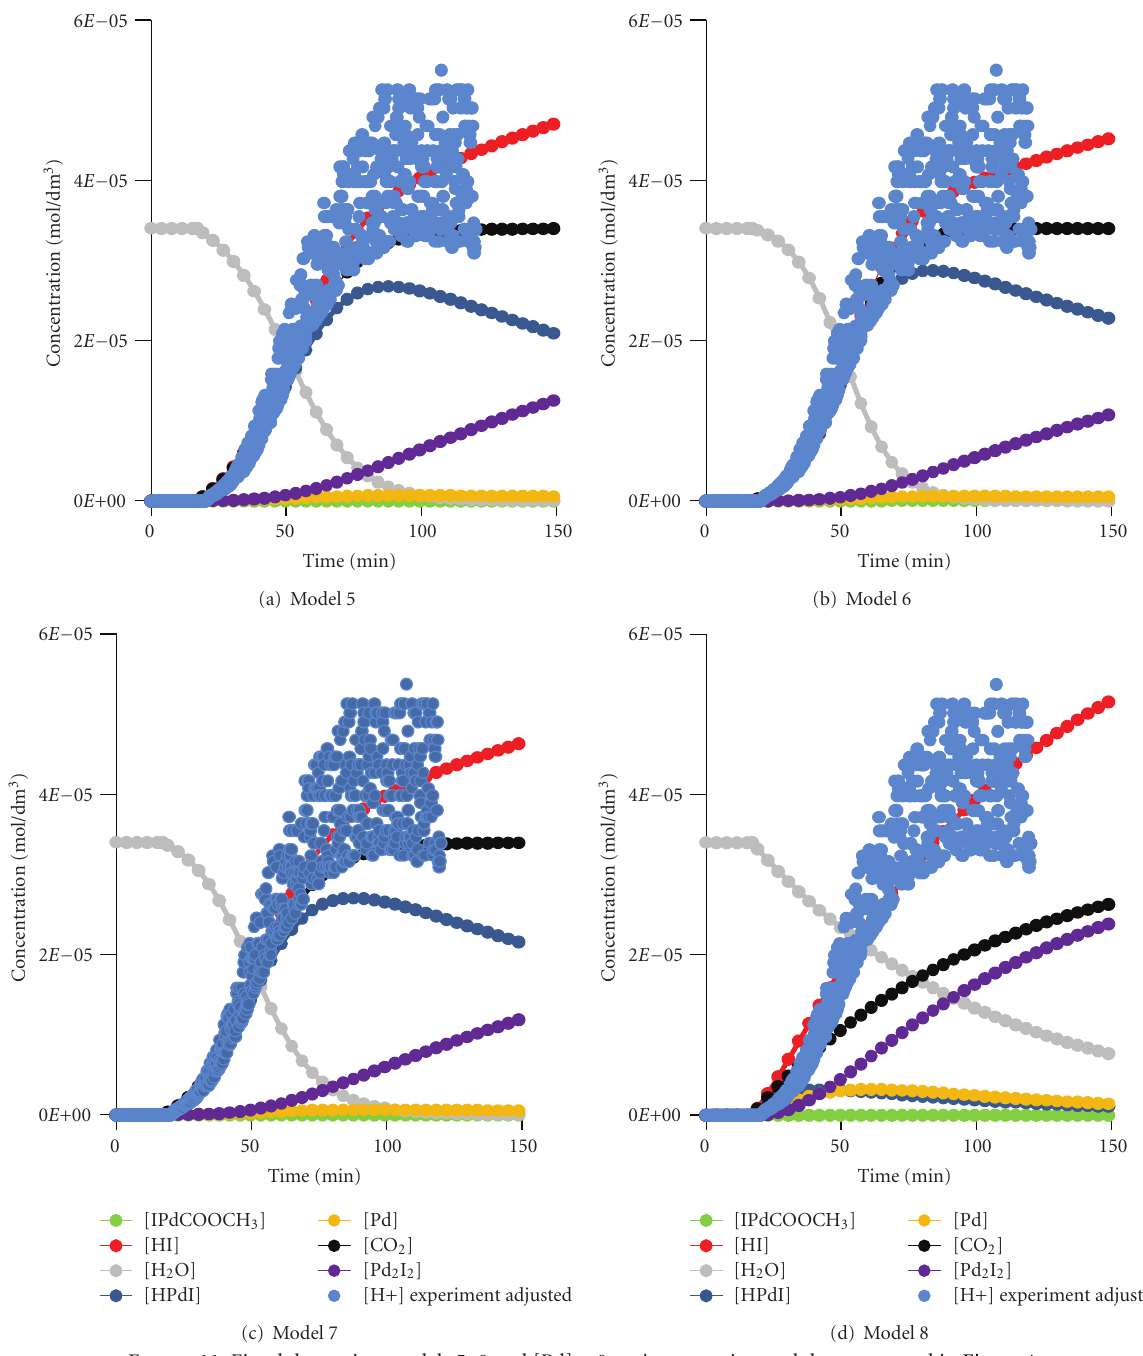
Figure 11: Fitted data using models 5–8 and [Pd] = 0 against experimental data presented in Figure